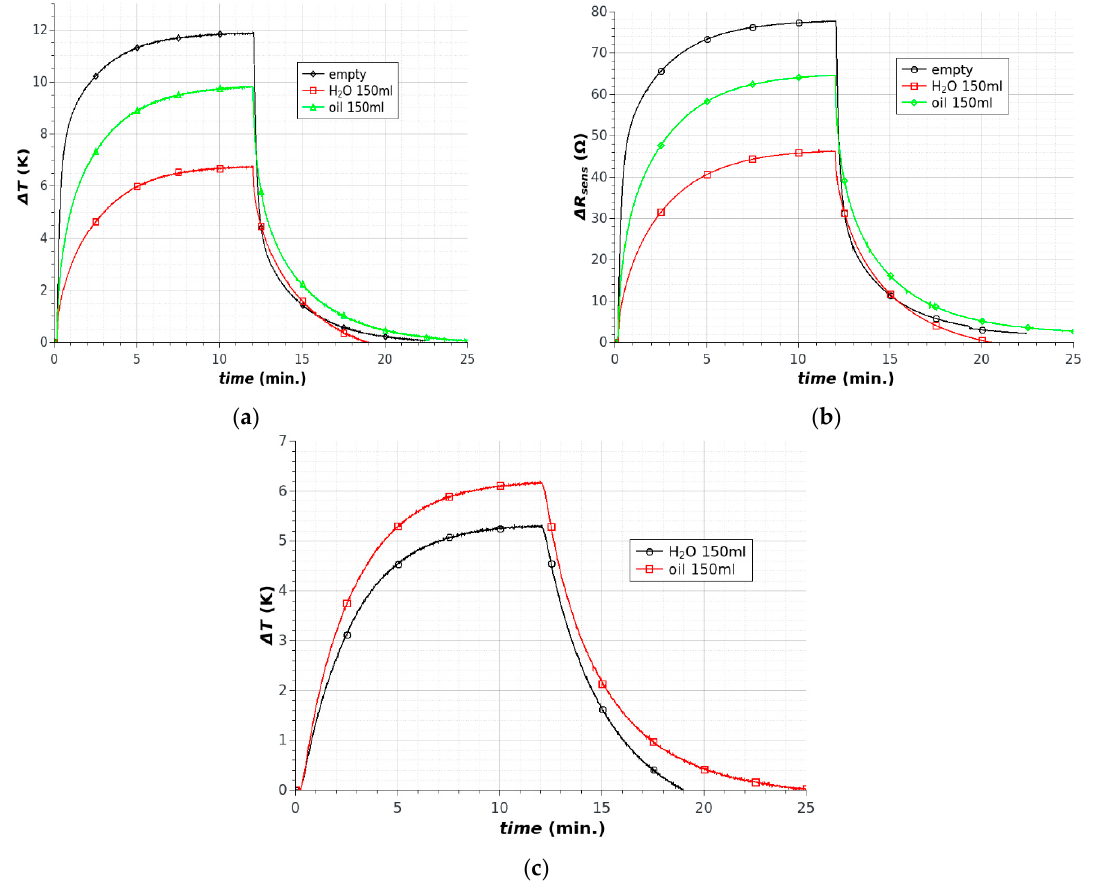
Figure 8. Heating microstructures with chambers at room temperature: ( a ) temperature changes; ( b ) sensor resistance changes; ( c ) temperature changes for liquid inside chambers.